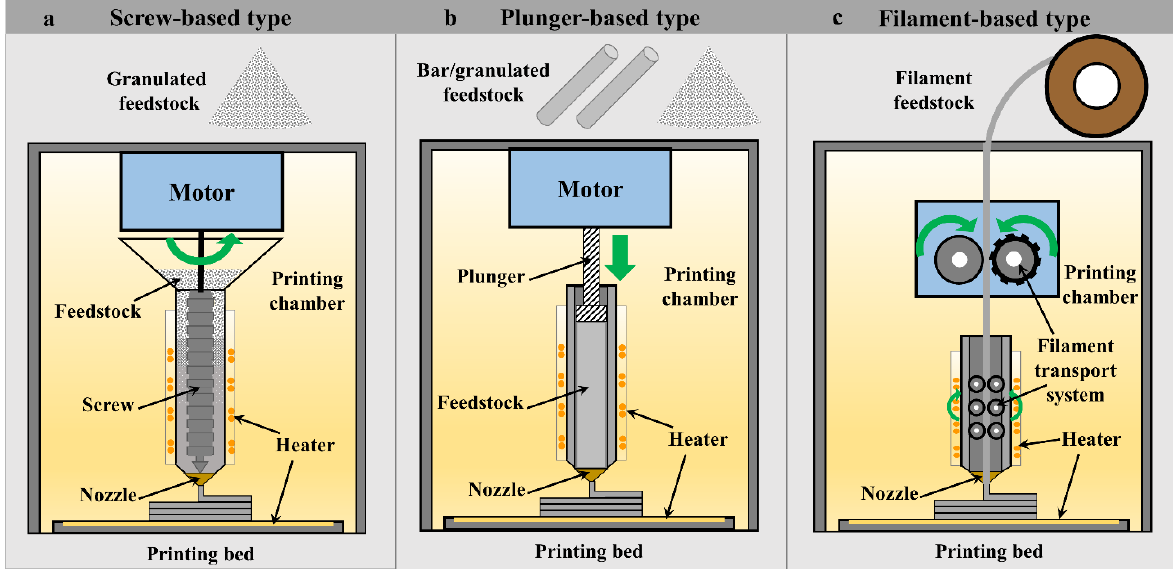
Figure 3. Types of material extrusion additive manufacturing classified by feeding system: ( a ) screw-based, ( b ) plunger-based and ( c ) filament-based